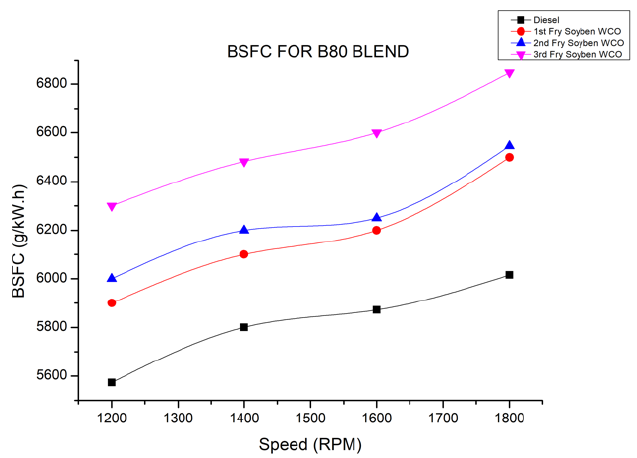
Figure 3. BSFC of different fry oils (B80 blend) at different rpm.